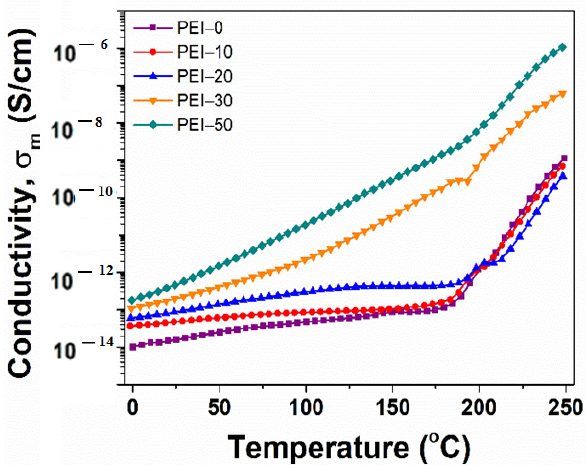
Figure 9. Temperature dependences of the measured conductivity at 1 Hz for the simple PEI-0 and the nanocomposites PEI-10, PEI-20, PEI-30, and PEI-50. Table 4. Numerical values of the measured conductivity derived at 1 Hz and temperatures around room temperature (T = 25 °C), below T g (T = 150 °C), and above T g (T = 250 °C) for the PEI and PEI/CoFe 2 O 4 films.